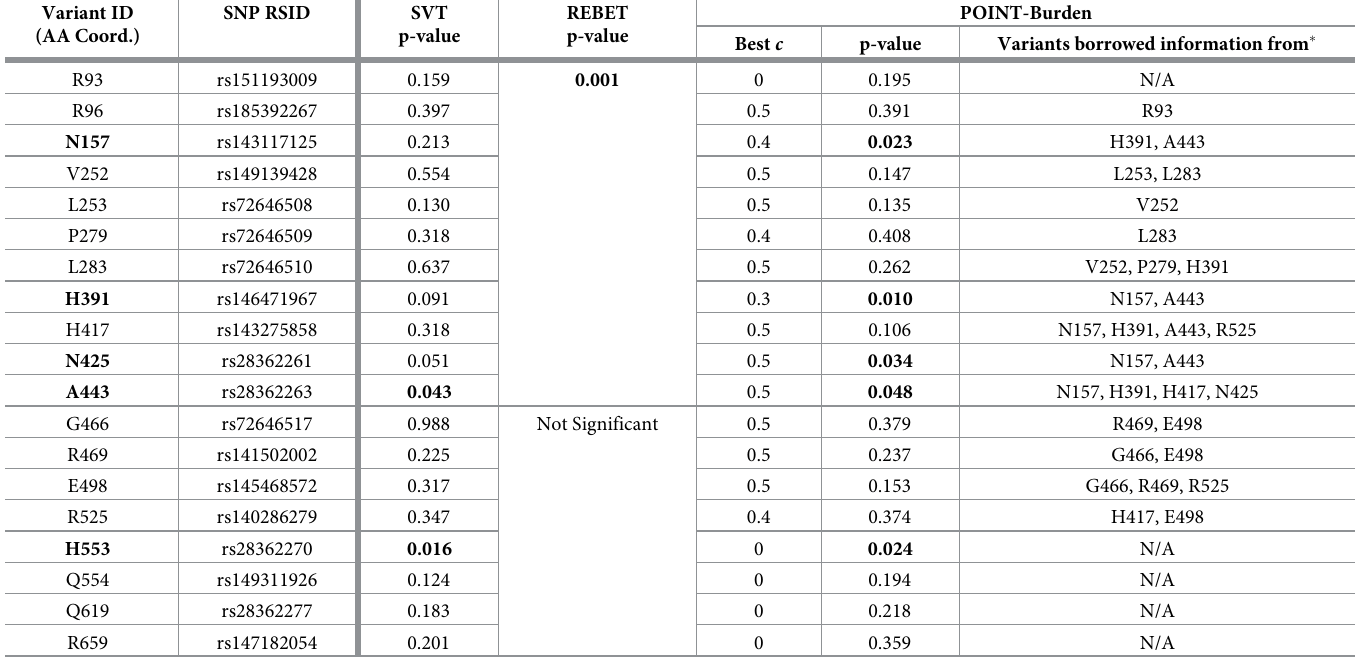
Table 4. PCSK9 analysis results summary. Results of PCSK9 analysis using the single variant test (SVT), REBET, and POINT (POINT-Burden). Promising variants are selected using the criterion of p-value < 0.05 and are shown in bold font. Variant ID (AA